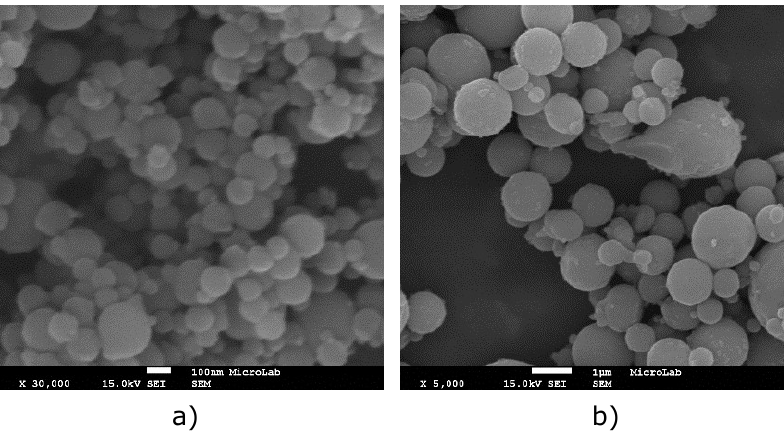
Figure 2. SEM images of aluminum particles ( a ) 40 nm and ( b ) 5 µ